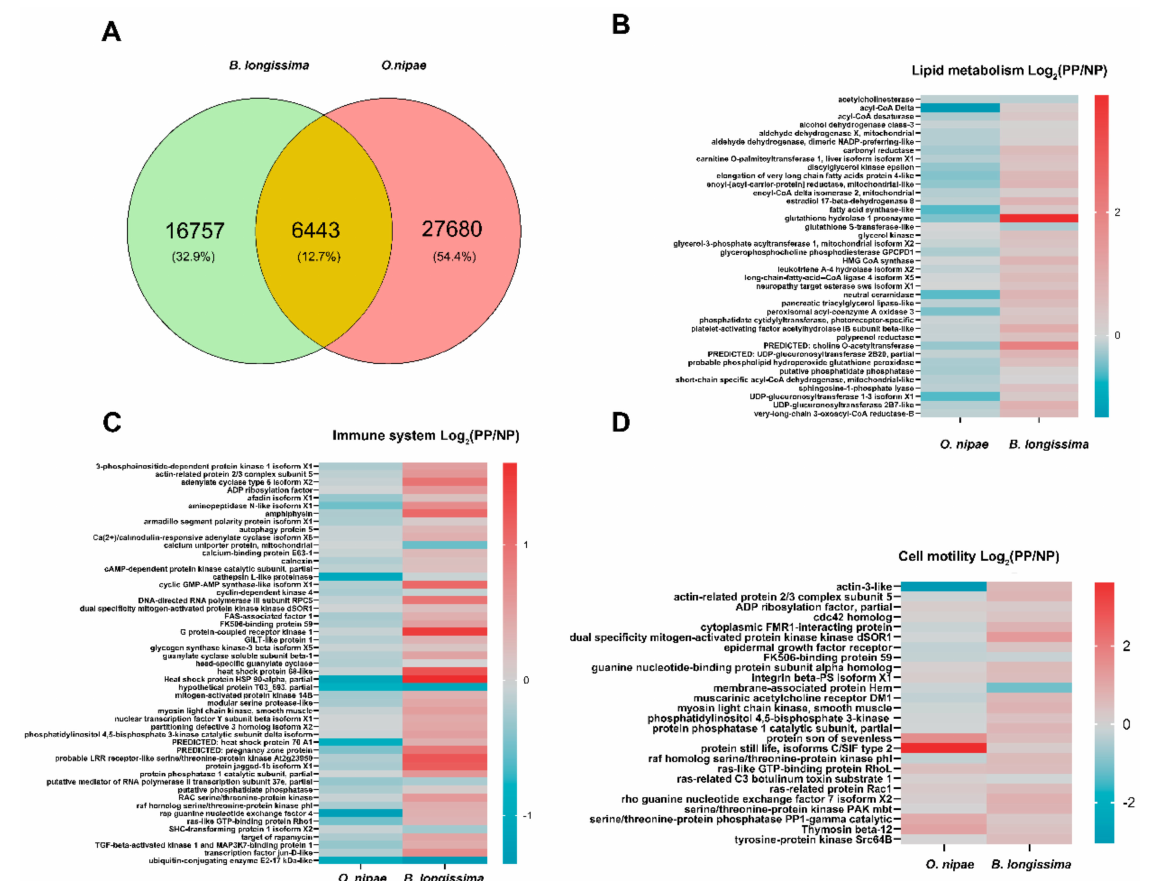
Figure 7. Comparison of transcriptomic analysis of B. longissima and O. nipae . ( A ) Homology analysis of O. nipae and B. longissima unigenes with a 70% coverage and an E-value cut-off of 10 − 5 ; ( B – D ) Differential expression analysis of lipid metabolism-related ( B ), immune system-related ( C ), and cell motility-related ( D ) homology genes in O. nipae and B. longissima between non-parasitised (NP) and parasitised pupae